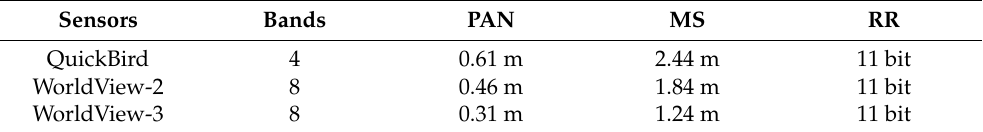
Table 1. Spatial and radiometric resolution (RR) and number of bands for the satellite datasets. Sensors Bands